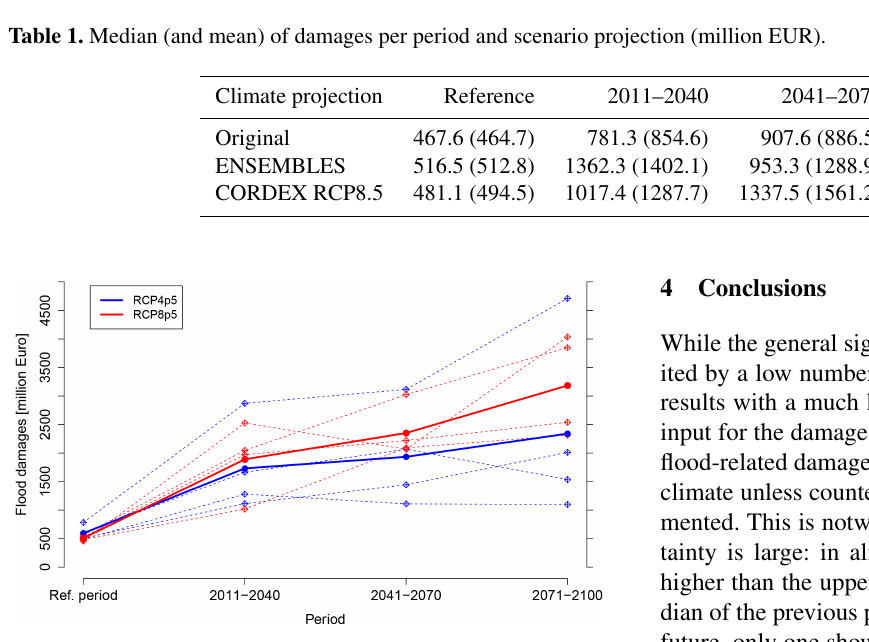
Figure 2. Comparison of impacts on monetary losses when using RCP4.5 or RCP8.5 scenarios as climate drivers. The dashed lines show the single runs; the solid lines represent the averages per pe-